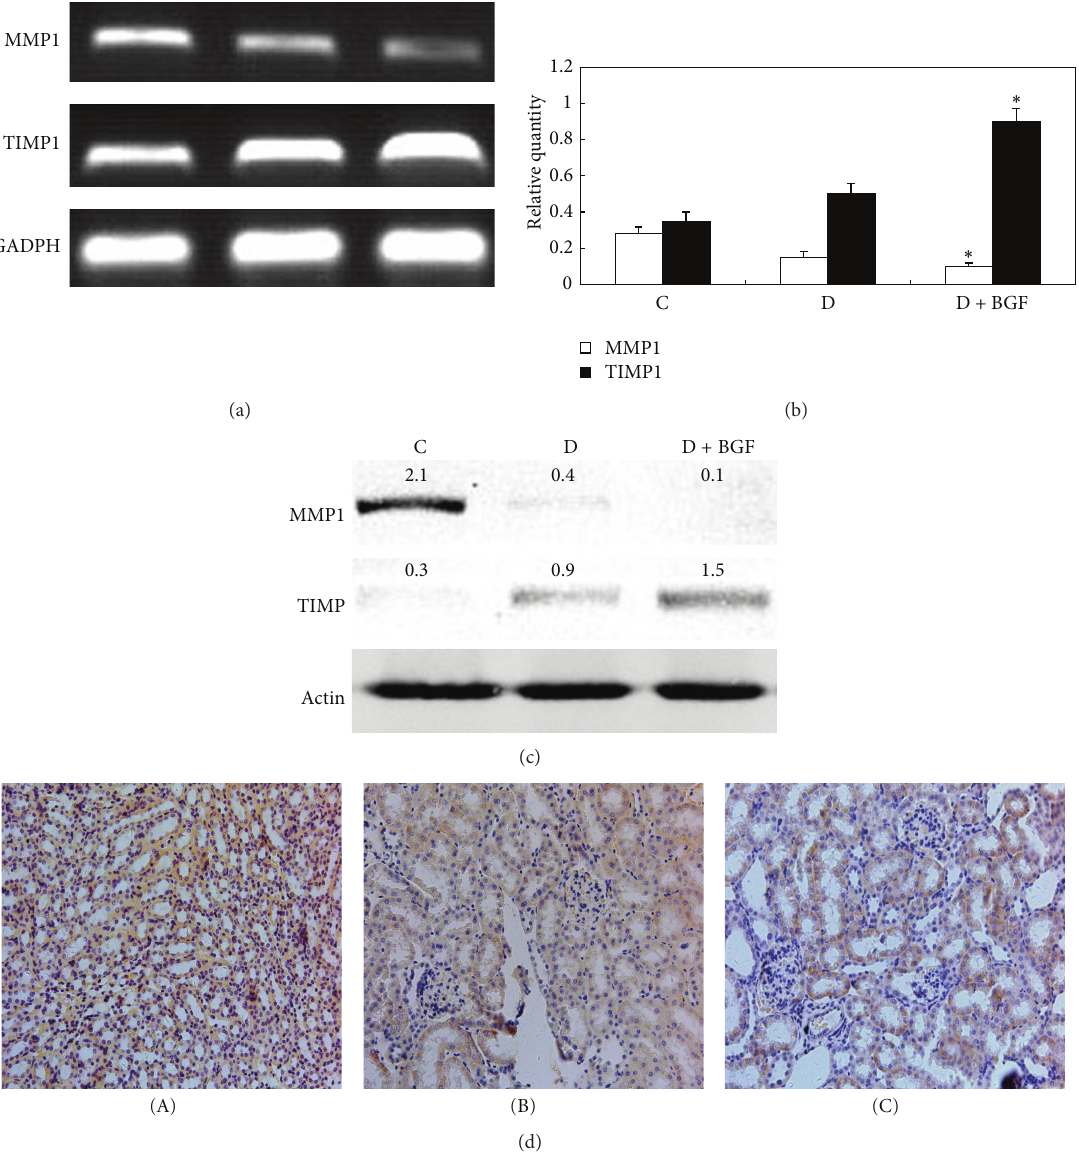
Figure 3: BGF treatment inhibited MMP1 and activated TIMP1. (a) MMP1 and TIMP1 expression in the kidney was evaluated by RT-PCR. (b) GAPDH was used as an internal control. PCR products were semiquantified according to the ratio of type I procollagen mRNA to GAPDH mRNA (b). Data are expressed as the mean ± SEM of three separate experiments. ∗ 𝑃 < 0.05 as compared to the control. (c) Western blot analysis depicted protein levels of MMP1 and TIMP1 in the kidney of mice. (d) Immunohistological staining of MMP1 in the kidney of mice. The rate of MMP1 positivity in the BGF-treated mice (C) was lower than the normal (A) and diabetic (B) mice. Magnification: